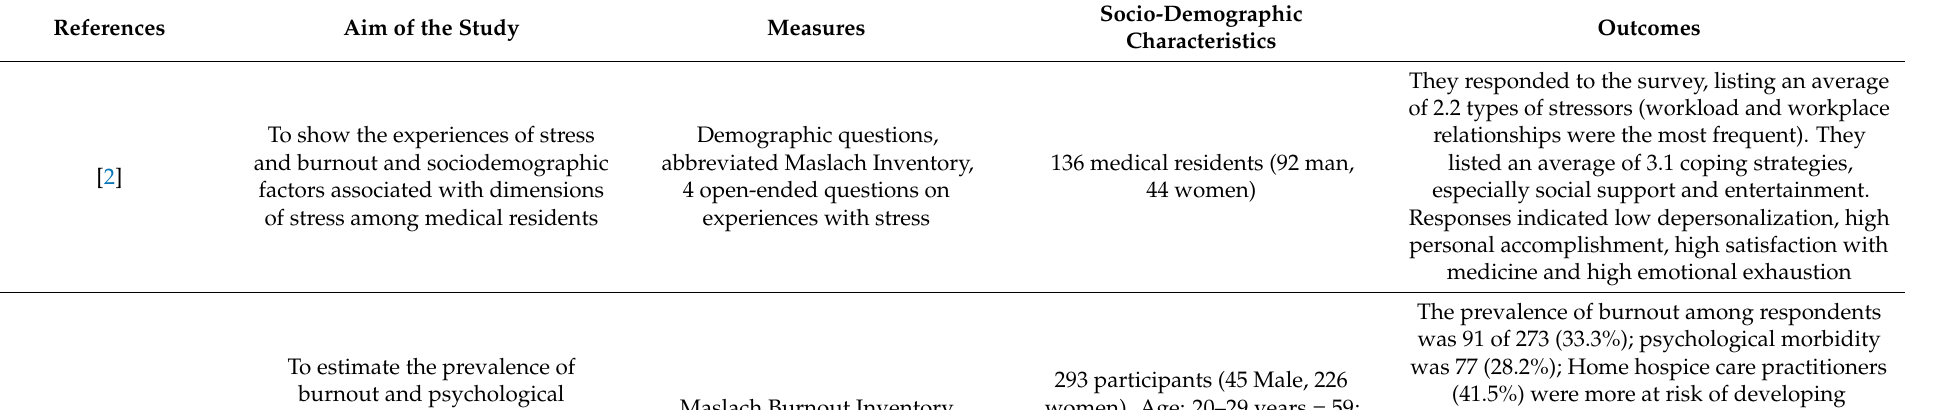
Table 1. Studies assessing Burnout Syndrome and coping